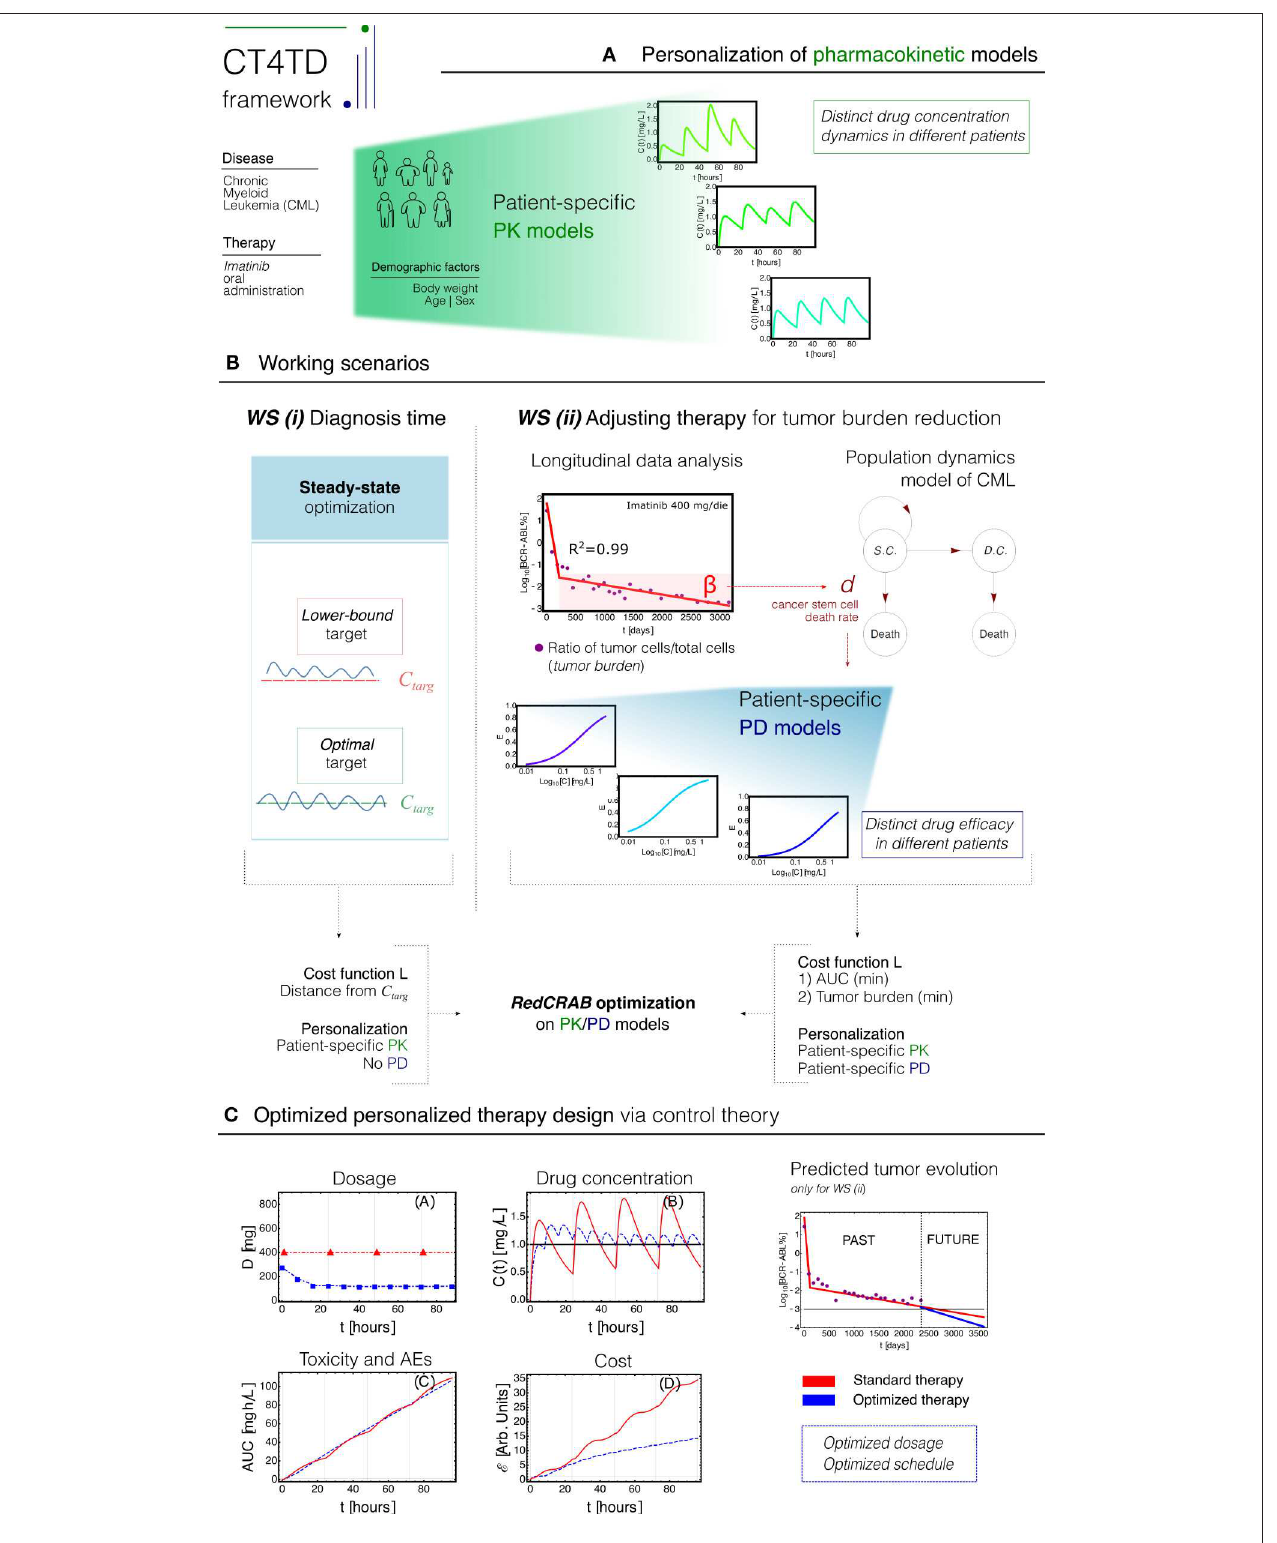
FIGURE 1 | CT4TD pipeline. (A) The CT4TD framework employs demographic factors such as body weight, age, and sex to define patient-specific parameters of the pharmacokinetic models. We here focus on the case of Imatinib administration in Chronic Myeloid leukemia (CML). (B) CT4TD manages two working scenarios: (i) at